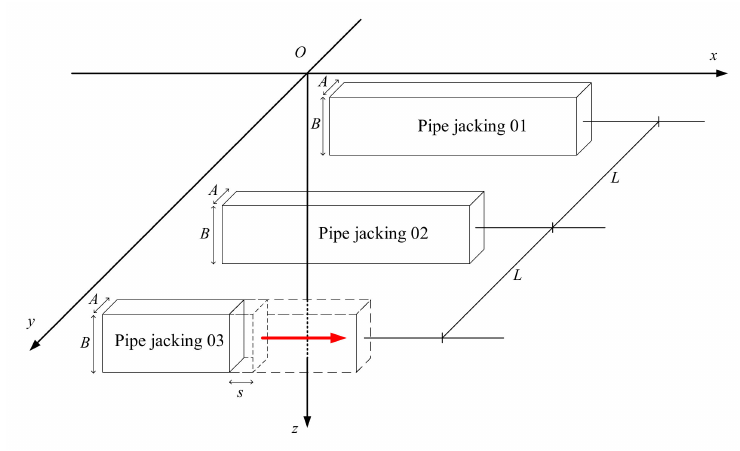
Figure 3. Schematic of calculation